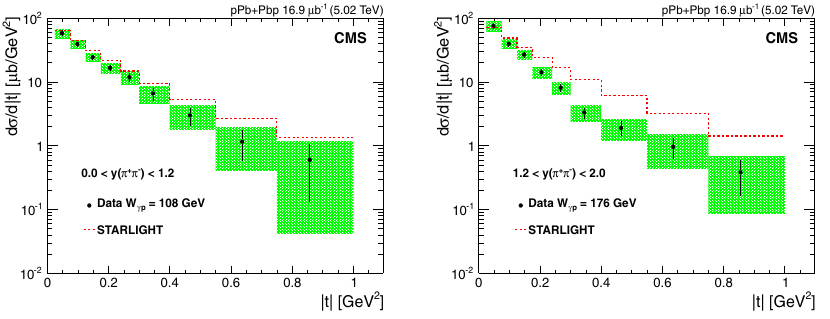
Figure 1. The left-side figure shows the invariant mass distribution of the exclusive dimuon candidates < 12 GeV that satisfy all the selection criteria, fitted to a linear function for in the range 8 < m µ + µ − the two-photon QED continuum (blue dashed line) plus three Gaussian distributions corresponding to the Υ (1S) , Υ (2S) , Υ (3S) mesons (dashed-dotted-red curves). The right-side figure shows the unfolded π + π − invariant mass distribution [4] in the pion pair rapidity interval y π + π < 2 fitted with the Söding − | | model [7]. The green dashed line indicates resonant ρ (770) 0 production, the red dotted line represents π + π − π 0 , the interference term, the magenta dash-dotted line corresponds to the background from ω → the black dash-dotted line represents the non-resonant contribution, and the blue solid line represents the sum of all these contributions.